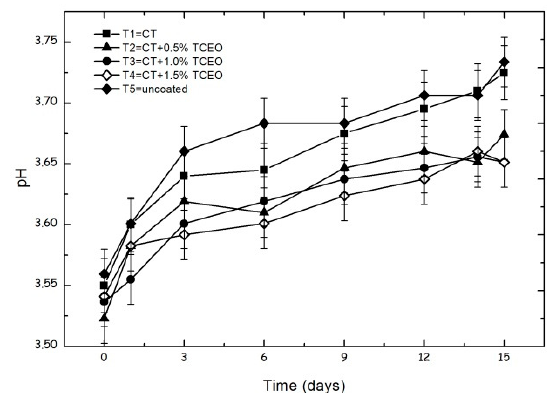
Figure 2. Evolution of pH in strawberries with chitosan (CT) and treatments of oil of Spanish Oregano (TCEO): T1 = CT, T2 = CT + 0.5% of TCEO, T3 = CT + 1.0% of TCEO, T4 = CT + 1.5% TCEO, and T5 = uncoated. Mean values and intervals of Fisher’s LSD of 95% according to the ANOVA test.